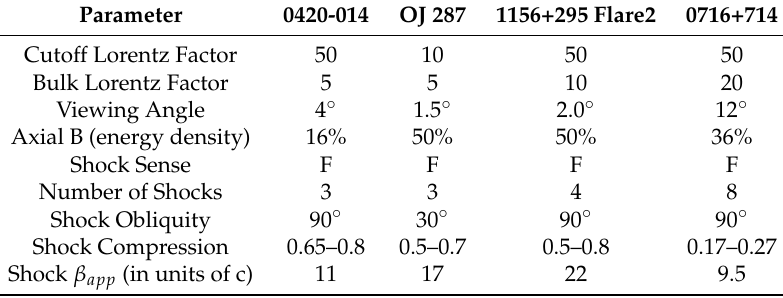
Table 2. Flow parameters and shock attributes from radiative transfer